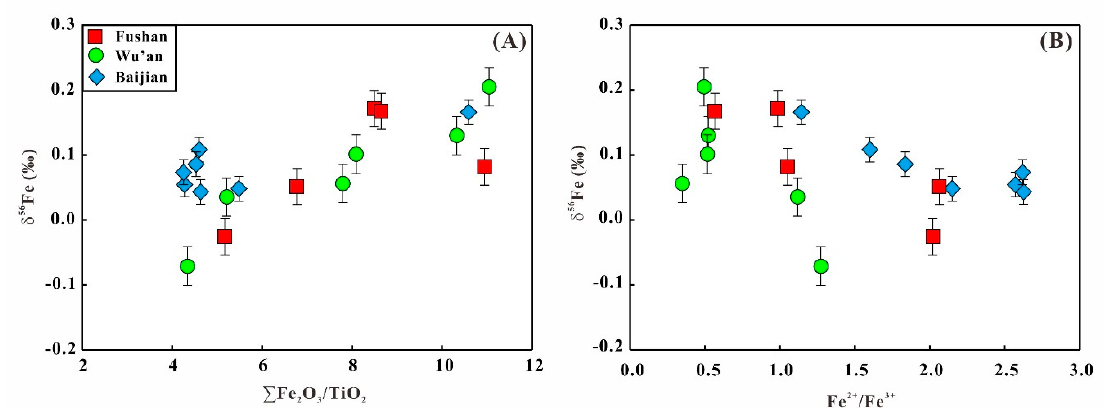
Figure 5. ( A ) Variations of δ 56 Fe values as a function of ∑ Fe 2 O 3 /TiO 2 ratios in diorites from the Han-Xing Fe skarn deposit. ( B ) Variations of δ 56 Fe values as a function of Fe 2+ /Fe 3+ ratios in diorites from the Han-Xing Fe skarn deposit. Data of Wu’an are from the reference [12]. Error bars indicate 95% CI of the mean.